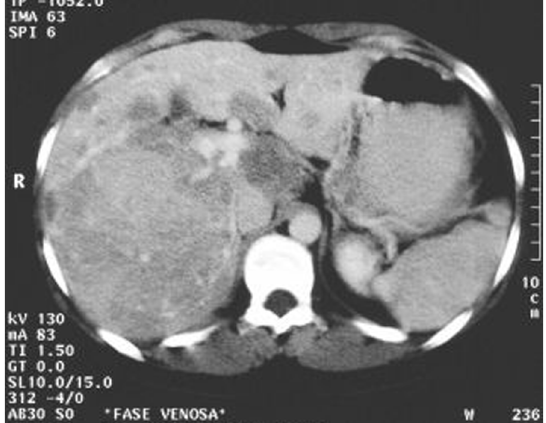
Figure 1 - Contrast-enhanced CT-scan showing multiple hypervas- cularized hepatic nodules, consistent with the diagnosis